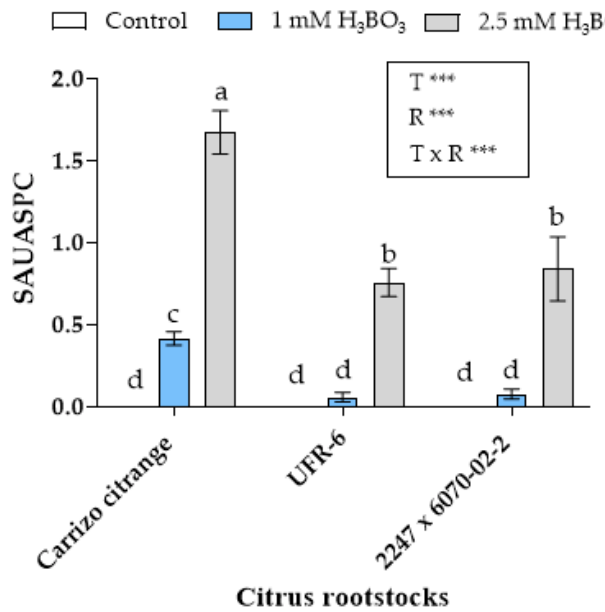
Figure 2. Mean standardized area under the abiotic stress progress curve (SAUASPC) under three toxicity boron treatments (Control, 1 mM H 3 BO 3 , and 2.5 mM H 3 BO 3 ) on three citrus rootstocks (Carrizo citrange; UFR-6 and 2247 x 6070-02-2) leaves over twenty-one days of treatments. Values in columns with different letters are statistical differences among treatments and rootstock by Fisher LSD test ( p < 0.05). Significant codes: *** = p < 0.001; T: treatment, R: citrus rootstock.